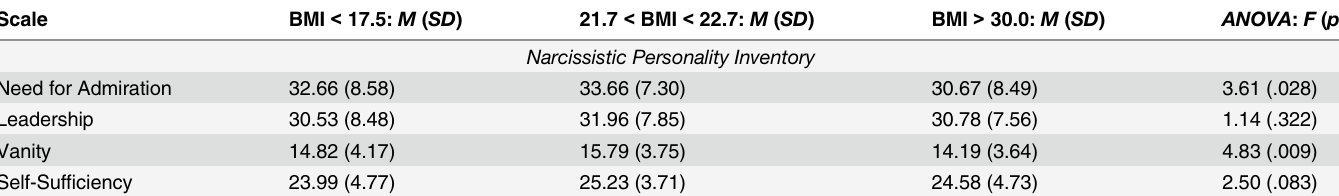
Table 3. Differences in the intensity of narcissistic traits in women with different BMI.